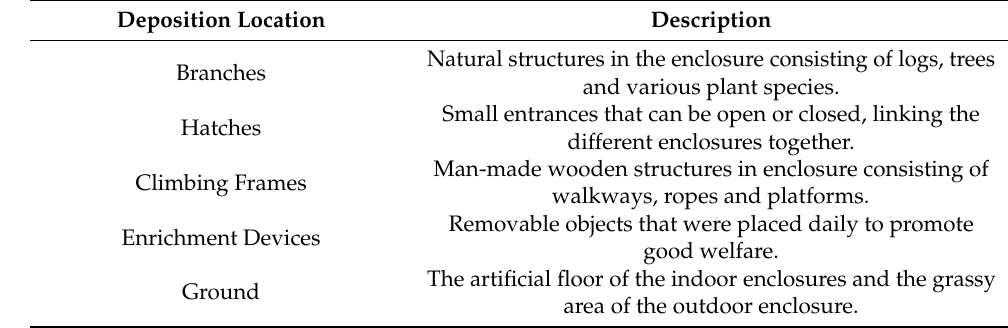
Table 2. Locations and definitions of possible scent-mark